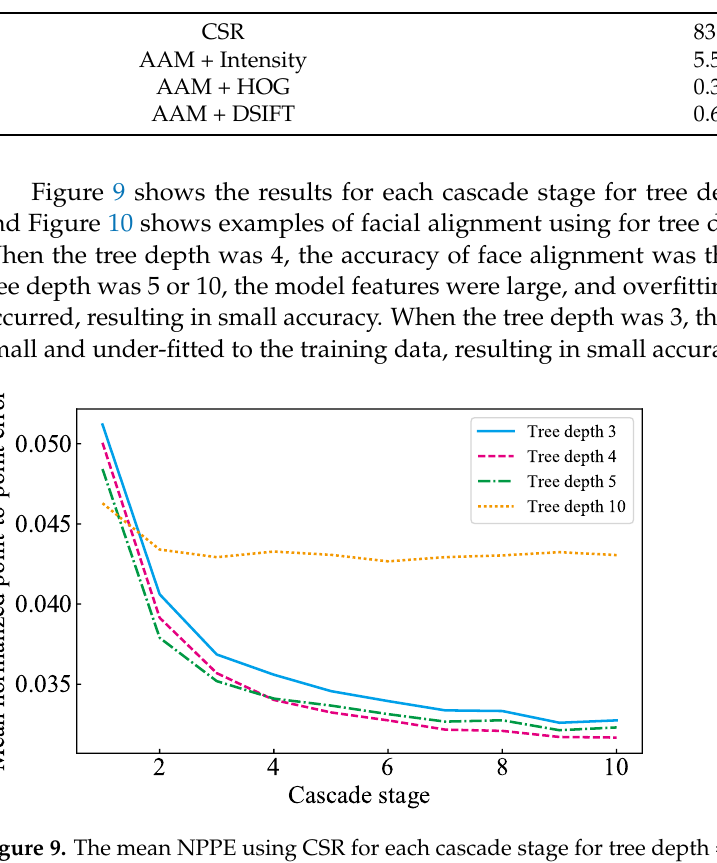
Figure 9. The mean NPPE using CSR for each cascade stage for tree depth = 3, 4, 5, and